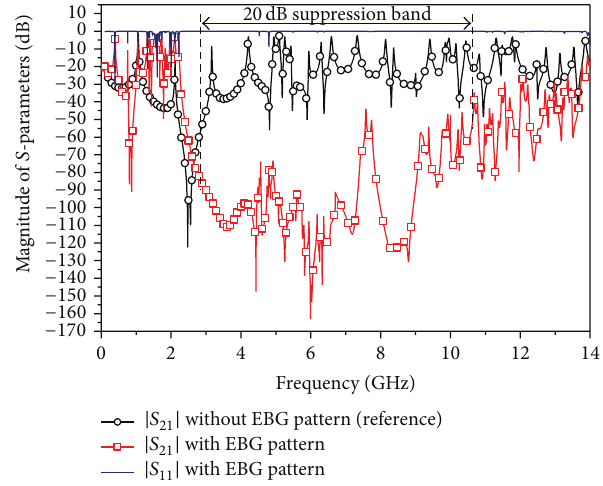
Figure 5: Magnitude of 𝑆 21 versus frequency for two setups: (i) the EBG-patterned parallel planes as shown in Figure 4 and (ii) the corresponding solid parallel planes as a reference. The EBG structures defined in the caption of Figure